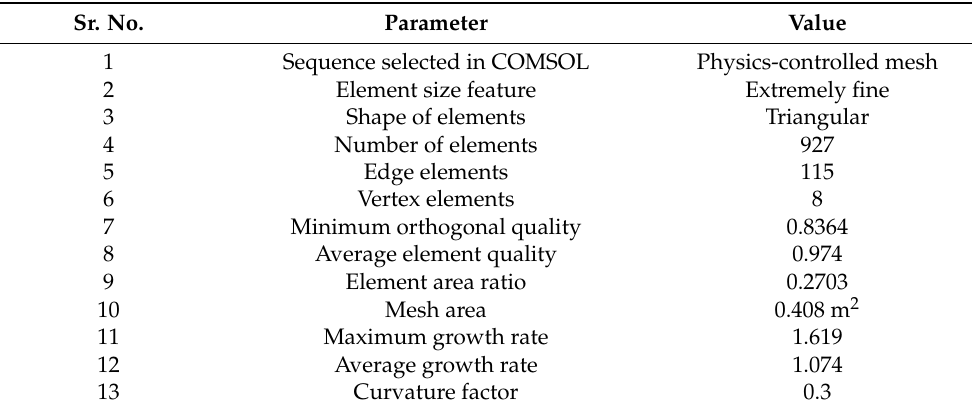
Table 1. Statistics of the mesh.